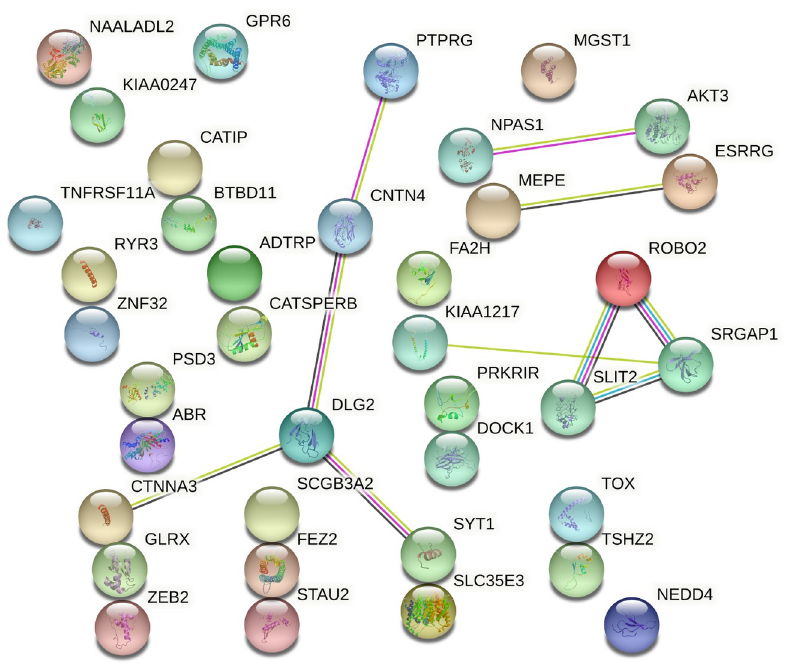
Fig 4. Protein-protein interaction (PPI) network analysis. PPI analysis was performed and visualized using the online tool STRING. Proteins are represented as nodes. Different colored lines represent types of evidence used for predicting PPIs (light blue line: known interaction from curated databases; pink line: experimentally determined evidence; grass green line: textmining evidence; black line: co-expression evidence).